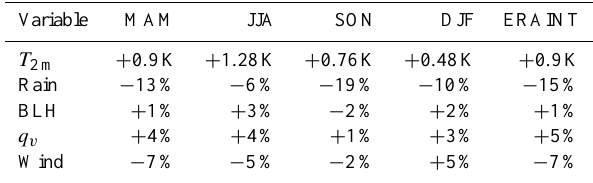
Table 2. Overview of the applied climate changes between the present day (2000–2009) and the near future (2026–2035) over Bel- gium per season. The right most column shows the annual mean difference between the ERAINT (based on the ERA-Interim re- analysis) and the Reference scenario. The variables presented here are 2m air temperature ( T 2m ) , total precipitation amounts (Rain), boundary layer height (BLH), 2m specific humidity ( q v ) and 10m wind speed (Wind).